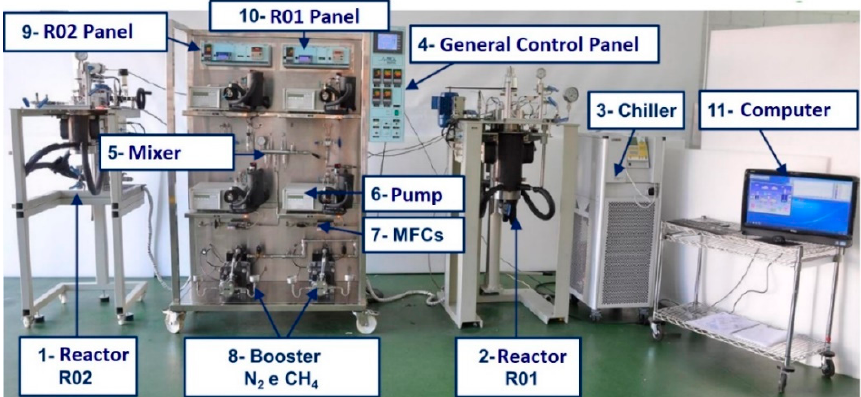
Figure 1. Main components of the pilot plant to study of gas hydrates: (1) Reactor R02 (1 L); (2) reactor R01 (10 L), (3) chiller, (4) general control panel, (5) gas mixer, (6) peristaltic pumps for liquefied gases (ethane, propane, CO 2 , and/or NH 3 ), (7) mass flow controllers (MFCs), (8) booster for N 2 and CH 4 , (9) R02 panel, (10) R01 panel, (11) controlling unit.